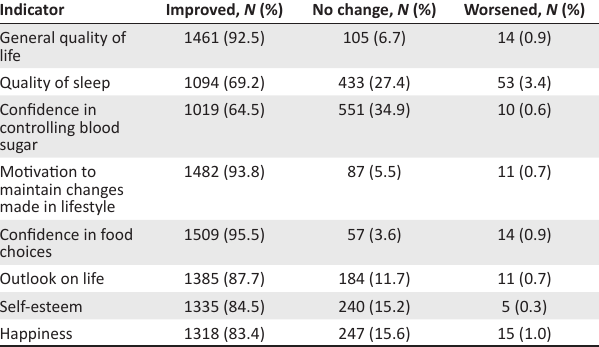
TABLE 9: Changes in physical and psychological well-being after starting low-carbohydrate